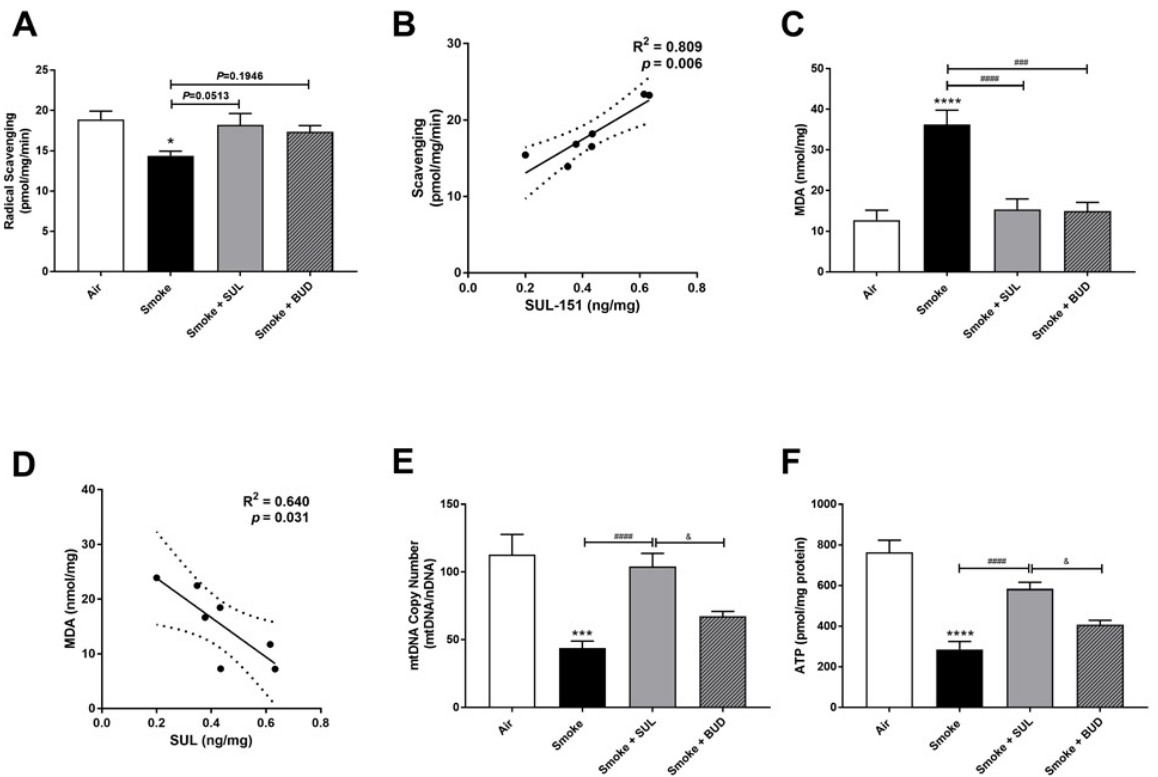
Figure 5. SUL-151 reduces the oxidative stress in the lungs after the development of CS-induced pulmonary inflammation. Mice were exposed to CS for 10 days (twice/day) and received SUL-151 or budesonide via oropharyngeal administration (once/day) 30 min before the first smoke exposure during the last 5 days of the CS exposure period. On day 11, lung tissue was collected, and the radical scavenging activity ( A ), MDA concentration ( C ), mtDNA copy numbers ( E ), and ATP levels ( F ) were measured. Correlation of radical scavenging activity and SUL-151 concentration in lung tissue ( B ) and the correlation of MDA and SUL-151 concentration in lung tissue ( D ) analyzed using Pearson r correlation test. Values are expressed as mean ± SEM. * p < 0.05, *** p < 0.001, **** p < 0.0001, smoke group compared to air group; ### p < 0.001, #### p < 0.0001, smoke + SUL group or smoke + budesonide (BUD) group compared to smoke group; & p < 0.05, smoke + BUD group compared to smoke + SUL group. n = 6–7 mice/group .